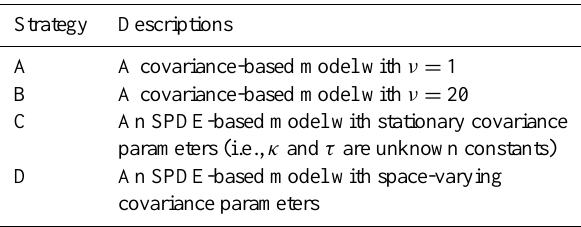
Table 1. Specifications of the different strategies in the spatial esti-